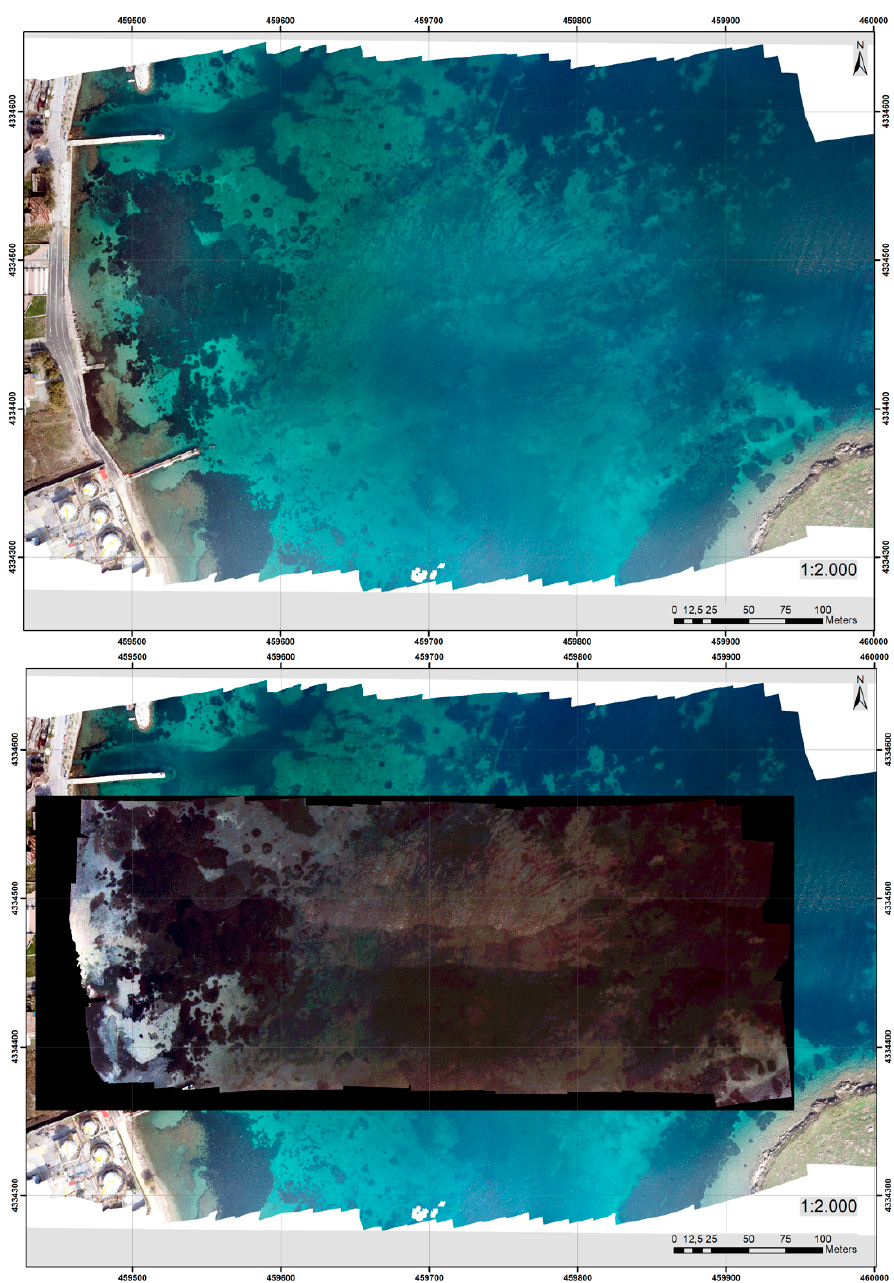
Figure 4. True-color RGB orthomosaic (top) and multispectral orthomosaic (bottom).